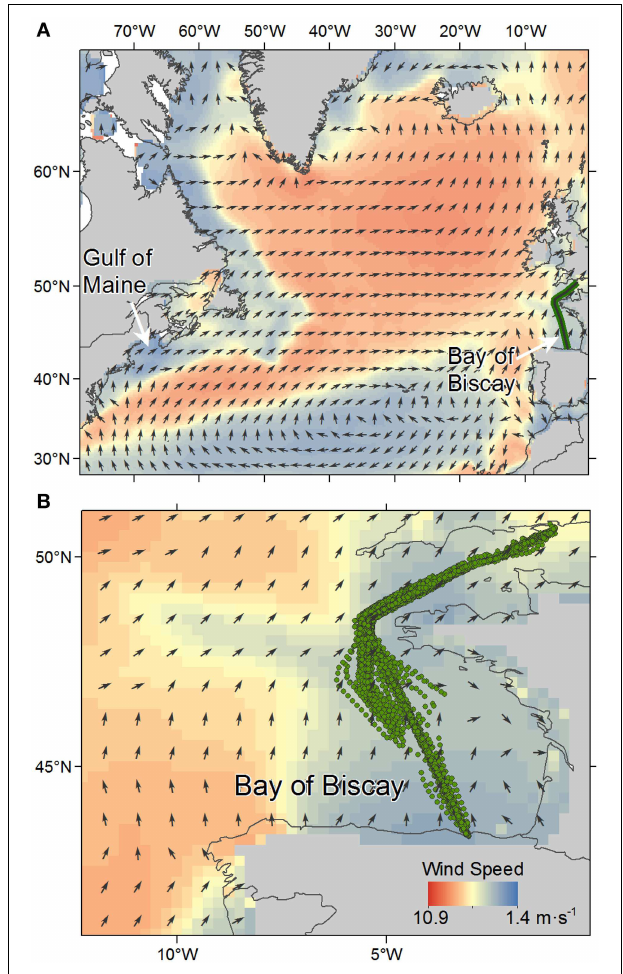
FIGURE 1 | (A) Map of the North Atlantic showing overall mean wind speed for August (1995–2009). Wind speed is graded in color. Arrows show wind direction. The main prevailing wind speed and direction is shown illustrating the facilitated flyway between the Gulf of Maine and the Bay of Biscay (BoB). Green line marks ferry trackline for surveys. (B) Survey map showing the effort during the 16-years study period in the BoB.